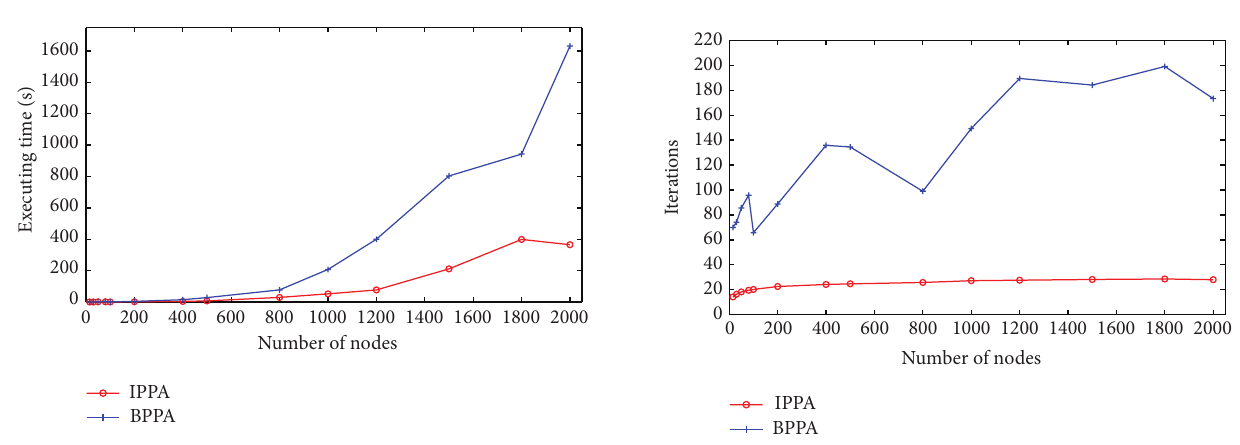
Figure 3: Comparison of executing time on randomly generated networks. IPPA refers to the improved Physarum polycephalum algorithm while BPPA represents the basic Physarum polycephalum algorithm.